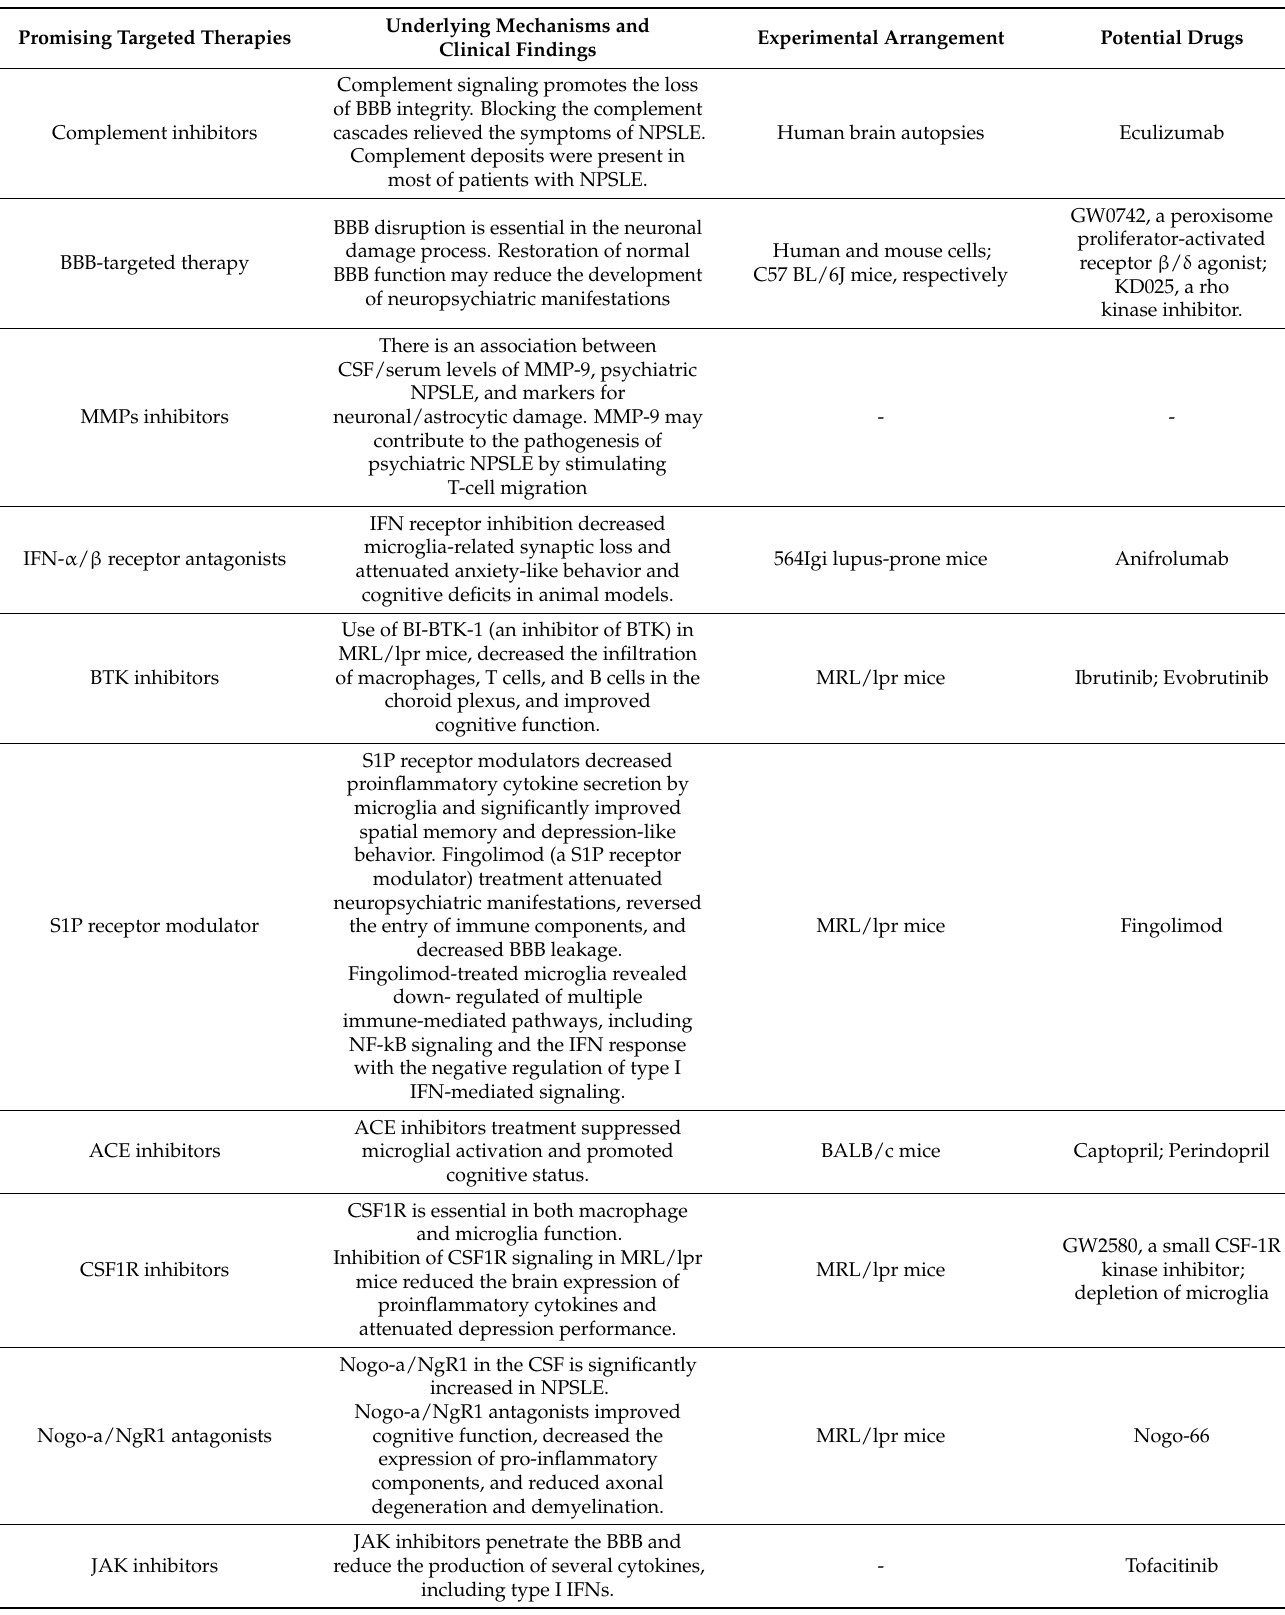
Table 1. Promising targeted therapies in